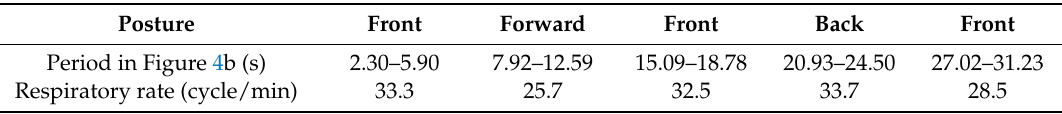
Period in Figure 4b